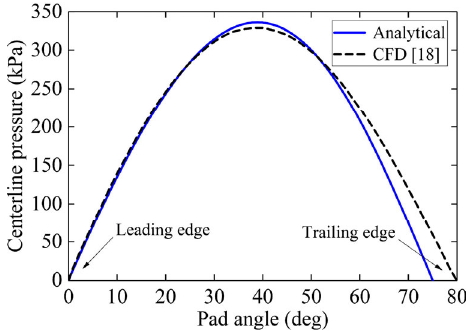
Fig. 2 Analytical and CFD solutions of water-lubricated pad centerline pressure for turbulent